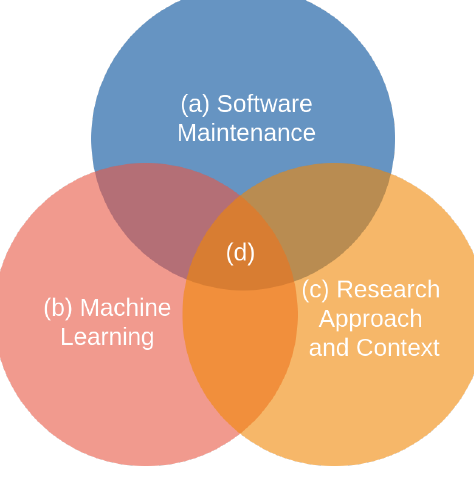
Figure 2. Study areas.